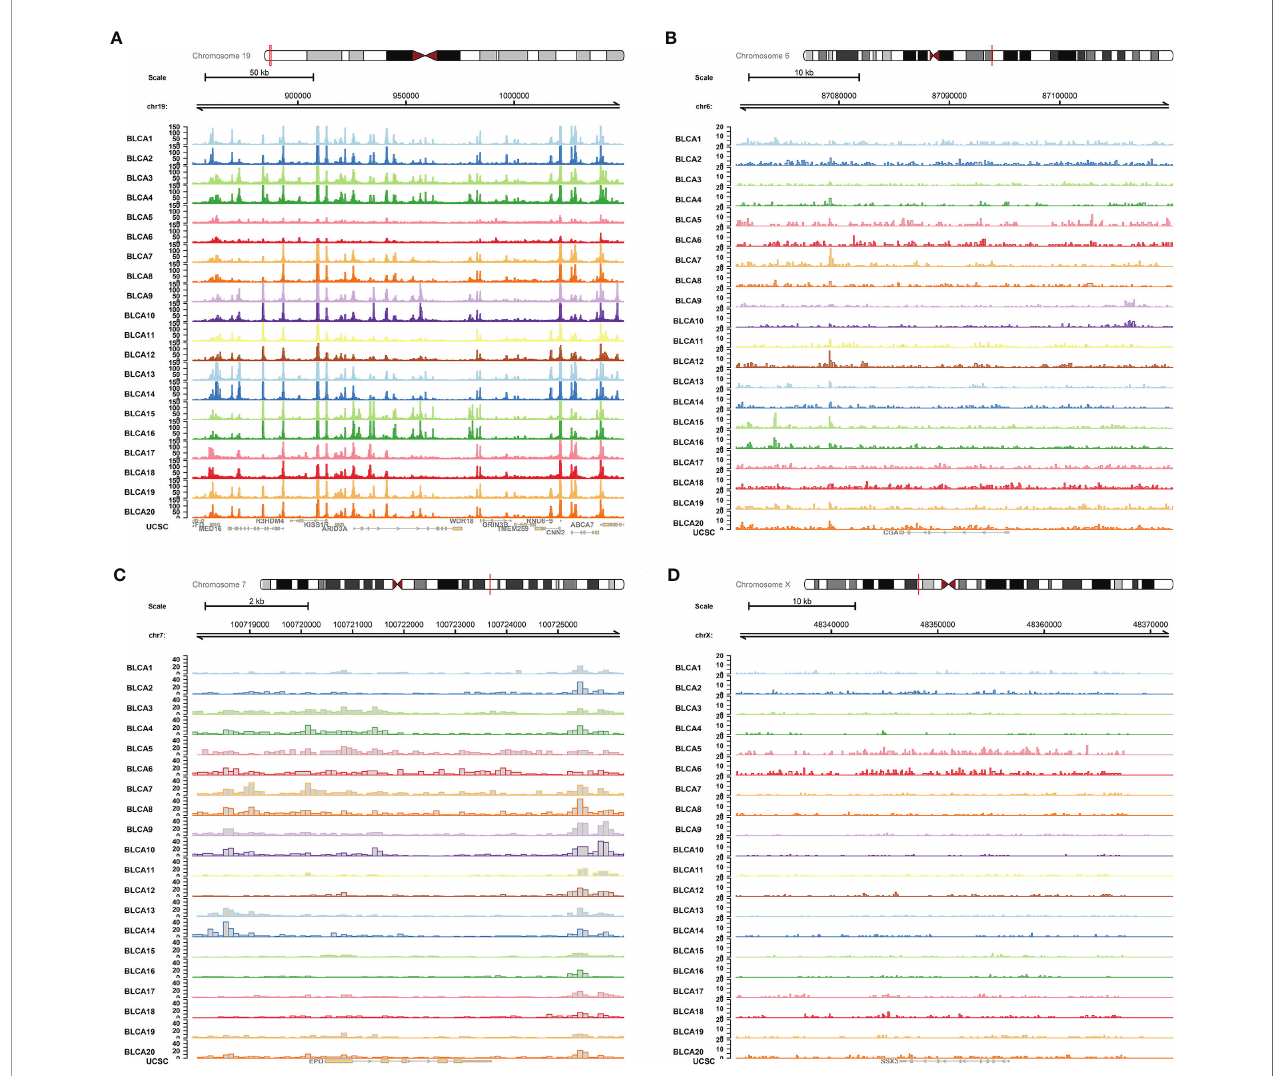
FIGURE 11 | ATAC-seq validation. ATAC-seq data of BLCA were used to validated the regulation mechanism of four key PRSGs [ARID3A (A) , CGA (B) , EPO (C) , SSX3 (D) ], illustrating their accessible peaks in the